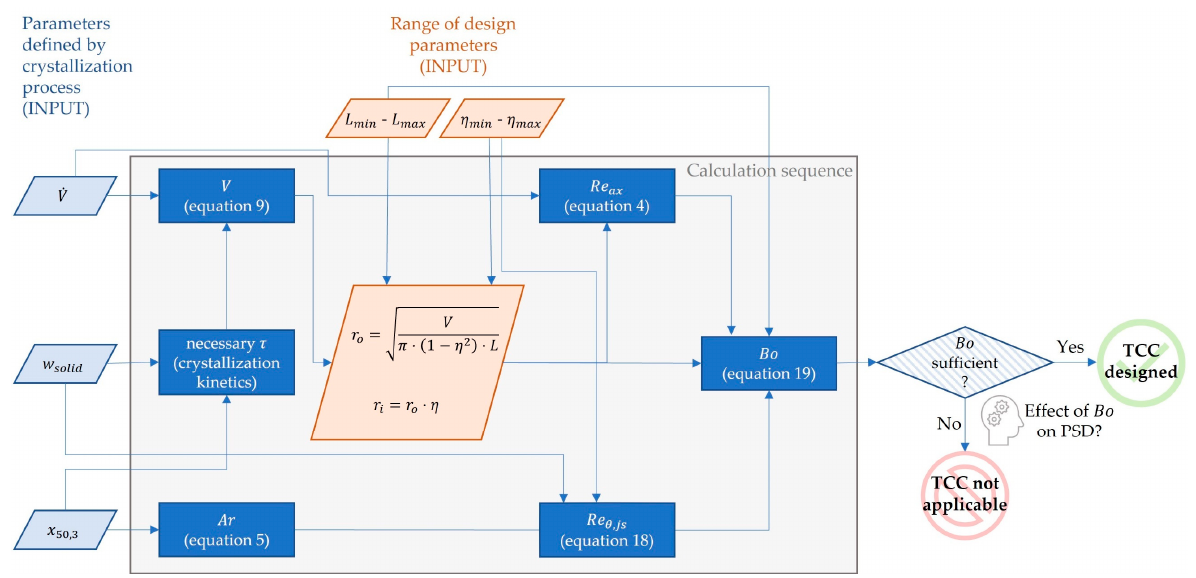
Figure 9. Calculation procedure for optimizing the TCC’s design parameters regarding the achiev- able Bodenstein number 𝐵𝑜 in a just-suspended state. The input parameter volume flow rate 𝑉(cid:4662) , particle mass fraction w solid , and median particle size x 50,3 were predefined by the crystallization process. By varying the design parameter length L and radius ratio η , Bo can be maximized. To decide whether the achievable Bo is sufficient to achieve the required PSD, the effect of Bo on the PSD needs to be investigated in another